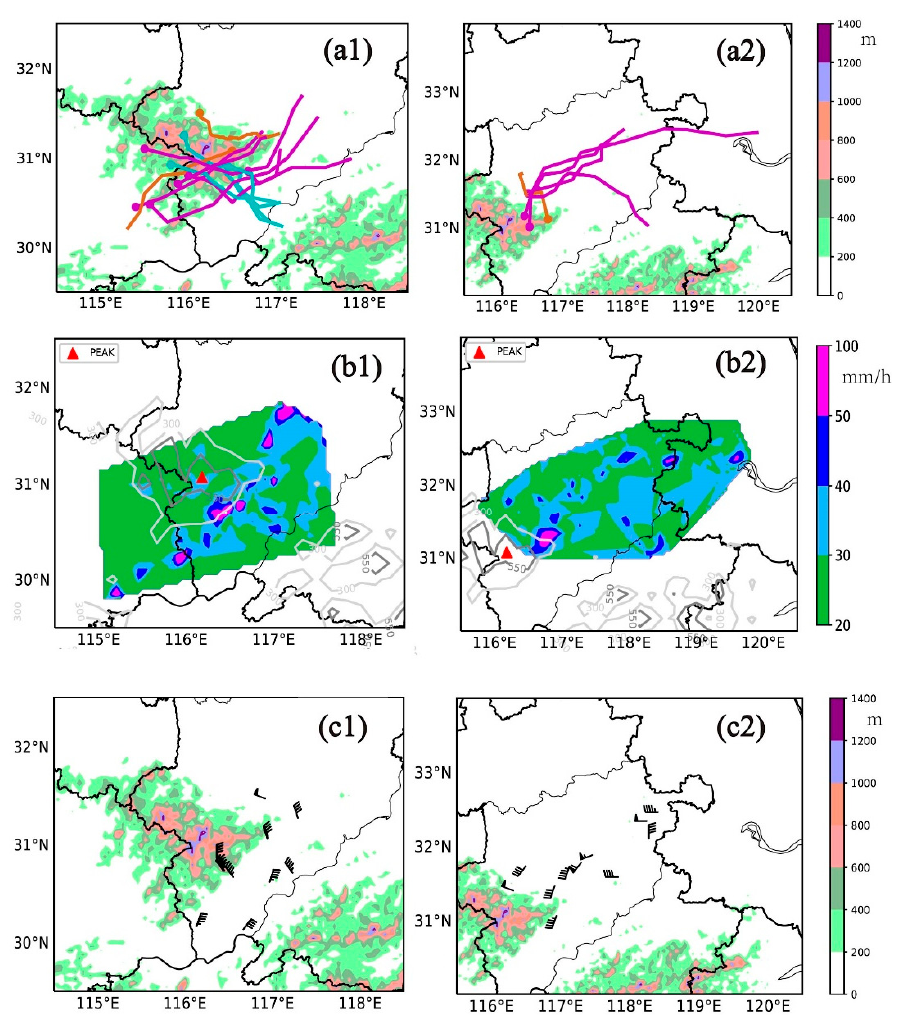
Figure 12. The tracks of ( a1 ) ‘South-Type’ and ( a2 ) ‘North-type’; the spatial distribution of maximum hourly precipitation (shaded, unit: mm/h)of ( b1 ) ‘South-Type’ and ( b2 ) ‘North-Type’; the spatial distribution of THWs (instantaneous wind speed ≥ 17 m/s) of ( c1 ) ‘South-Type’ and ( c2 ) ‘North-Type’. The shaded in ( a1 , a2 , c1 , c2 ) represent terrain height (unit: m). The contour in ( b1 ) and ( b2 ) represent terrain height (unit: m).